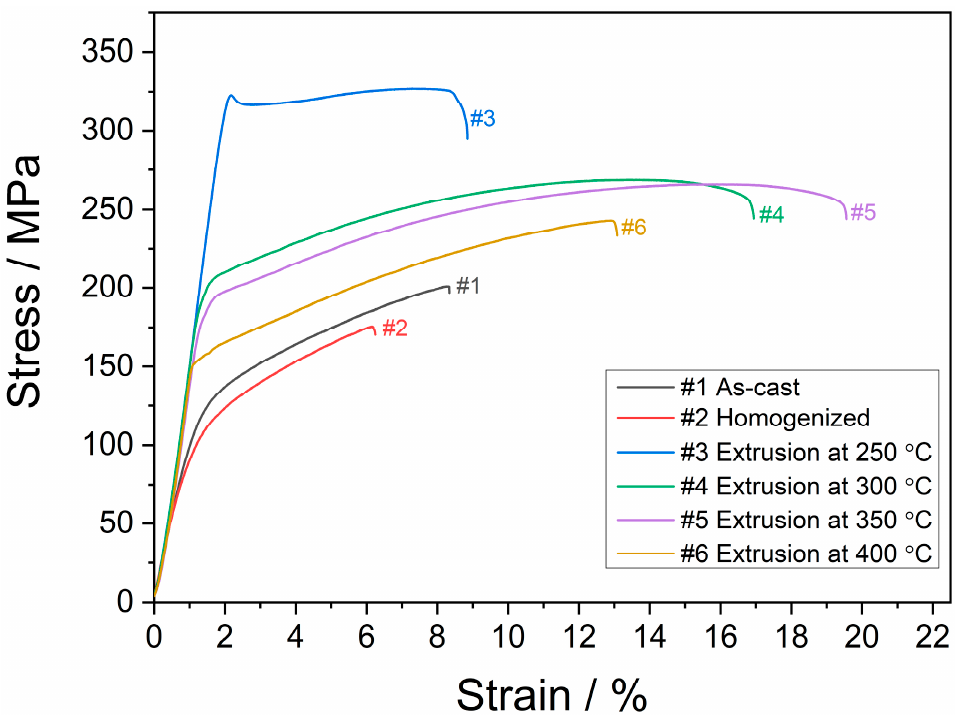
Figure 8. Engineering stress–strain curves for the as-cast, homogenized, and extruded alloys. Table 3. Tensile test results.